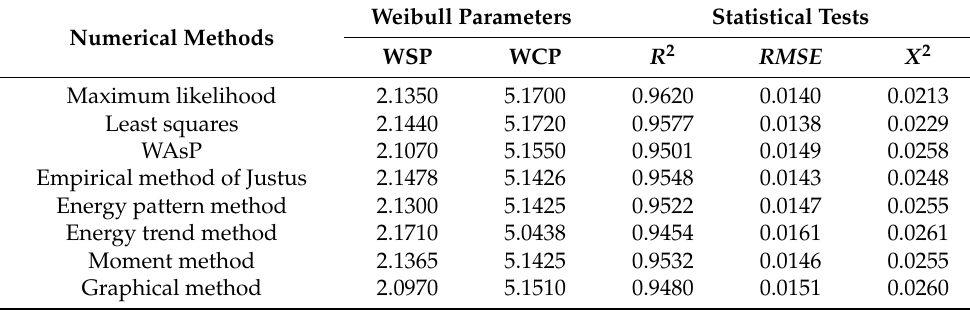
Table 4. Weibull parameters and statistical analysis for Gwadar.